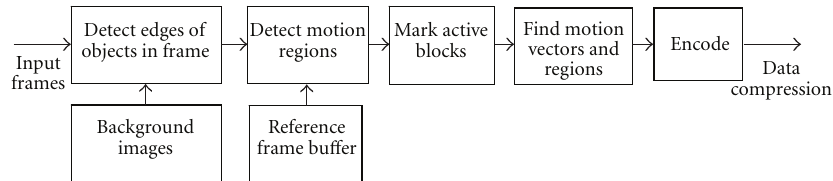
Figure 4: The proposed video compression algorithm.